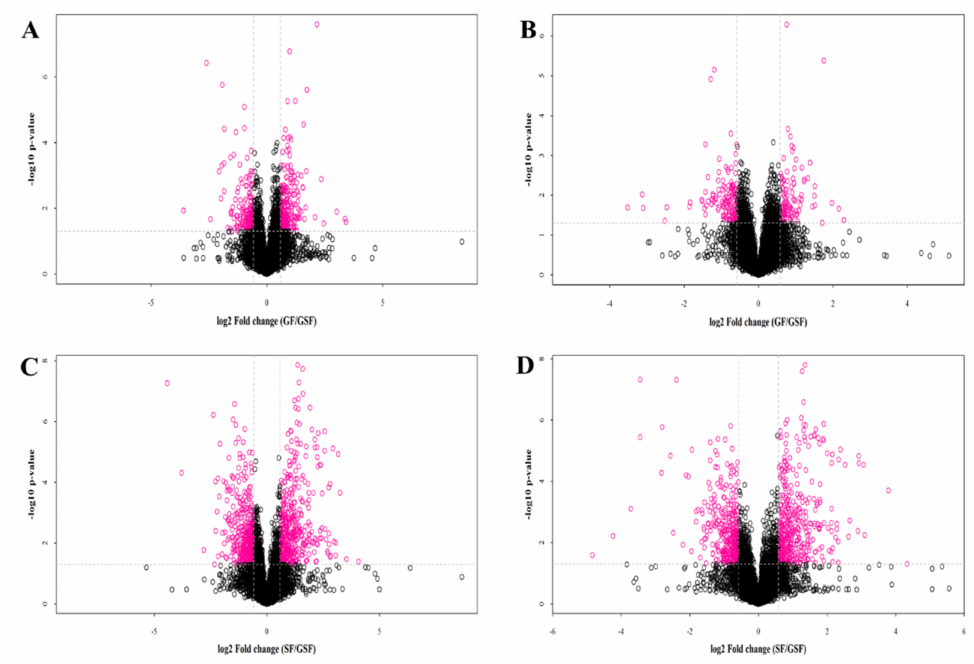
Figure 2. Volcano plot of Tan lamb metabolites under positive- and negative-ion modes in the GF vs GSF ( A , B ) and SF vs GSF ( C , D ) groups. GSF, graze-feeding group; GF, time-limited graze-feeding group; SF, stall-feeding group. n = 8 for each group. The black and purplish red points indicate non-significantly different metabolites and significantly different metabolites,